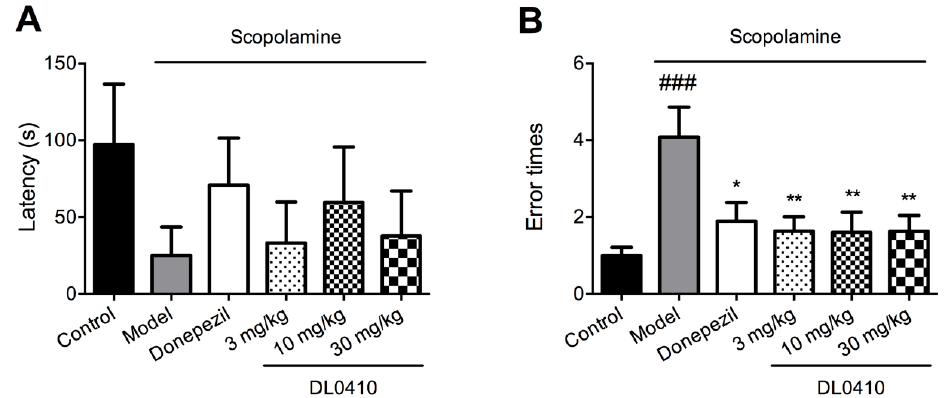
Figure 6. The effect of DL0410 on the escape learning task. Data were expressed as mean ± SEM ( n = 12). ( A ) The latency that mice took to firstly jump to the metal floor in the retention test. Scopolamine could induce mice to step down to the metal floor with shorter latency, and donepezil and DL0410 showed the tendency to extend the latency; ( B ) The error times of mice jump to the metal floor in the retention test. Scopolamine could induce mice to step more times down to the metal floor, and DL0410 could reduce the times of mice stepping down to the metal floor. ### p < 0.001 vs. the control group; * p < 0.05 and ** p < 0.01 vs. the model group.